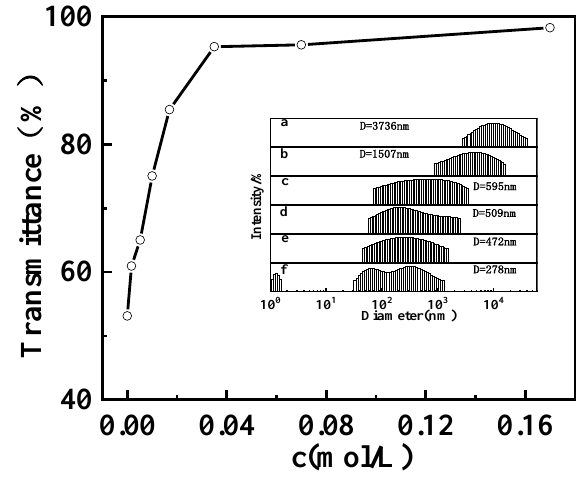
Figure 4. Optical transmittance at 600 nm for 10 mg/mL GPAM2 aqueous solutions as a function of HAc concentration at 20 °C. Inset displays the particle size of 10 mg/mL GPAM2 aqueous solutions with the HAc concentration of (a) 0.00175 M, (b) 0.0105 M, (c) 0.0175 M, (d) 0.0351 M, (e) 0.0702 M, and (f) 0.175 M.